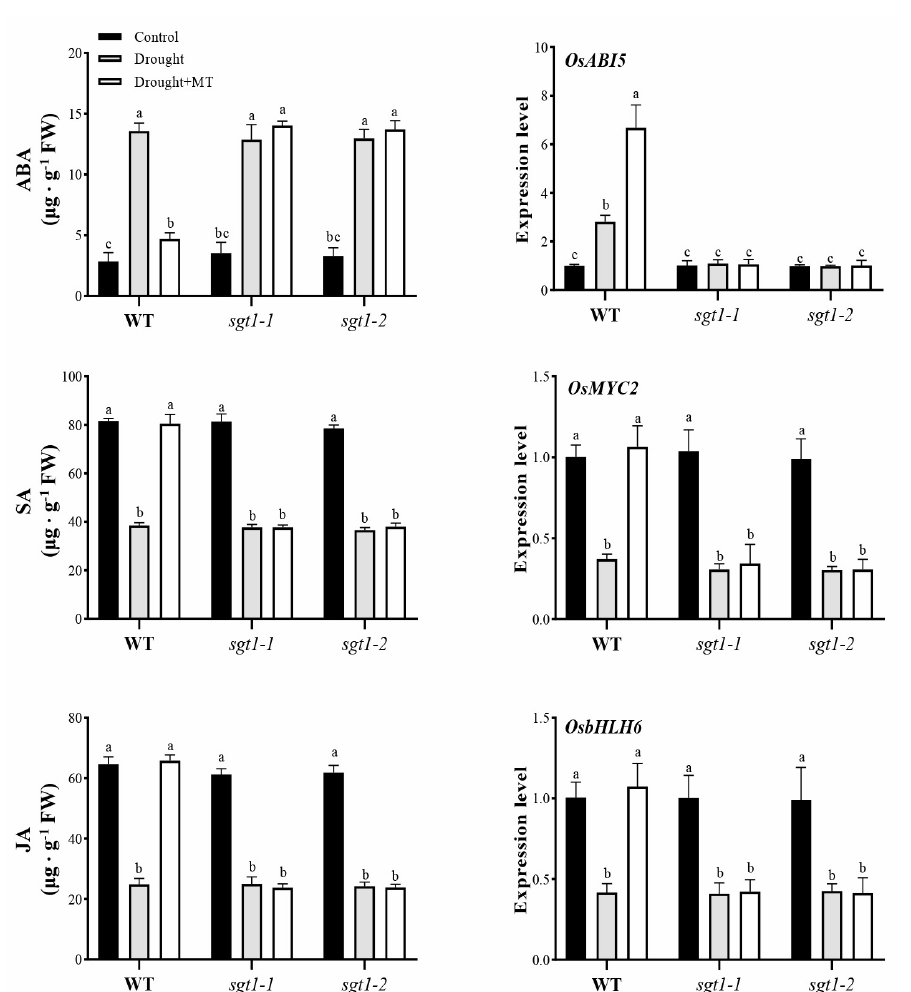
Figure 4. Effects of melatonin treatments on the endogenous phytohormones biosynthesis under drought stress. Contents of abscisic acid (ABA), salicylic acid (SA) and jasmonic acid (JA), as well as expression levels of OsABI5 , OsMYC2 and OsbHLH6, were examined in the leaves of wild-type (WT) and sgt1 mutant seedlings treated with melatonin (MT; 100 µM) under drought stress. Di ff erence in letters indicates signi fi cant di ff erences according to Tukey’s Multiple Comparison Test ( p < 0.05).